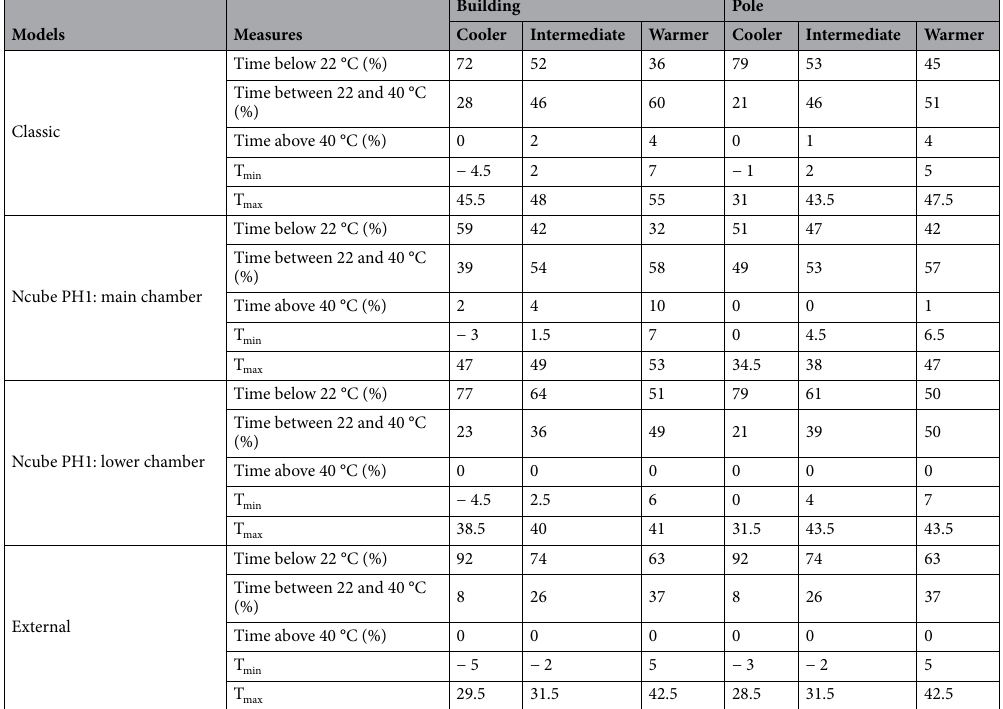
Table 2. Percentage of time below, between, and above the extended optimal temperature range of 22–40 °C, and minimal and maximal temperature in Classic bat boxes, Ncube PH1 bat boxes, and outside (external temperature) from mid-May to mid-September 2019 in Quebec, presented per climatic and mounting